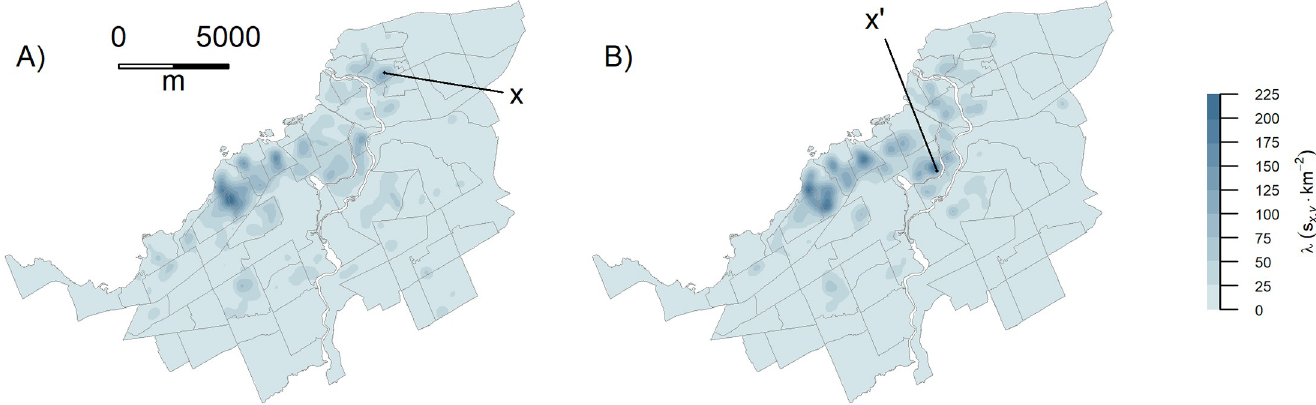
Fig 5. Comparison between model detections and building permits. A) Kernel density surface of SCNN-FC-8 detections; B) KDE of building permits. Both panels represent data from 2011 onwards. See text for the explanation of the labelled locations (x is within Vanier North neighbourhood and x’ is within a neighbourhood named Glebe-Dow’s Lake). Also see Section D.3 in S1 Appendix for furthur